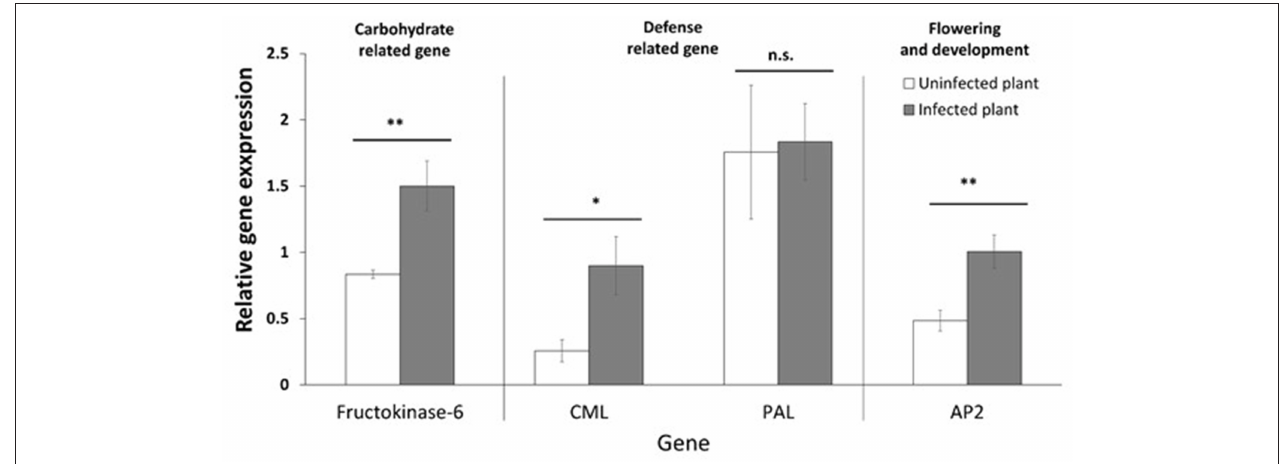
FIGURE 6 | Relative gene expression (mean, ± SE) of selected genes. Asterisk indicates statistically significant differences (* p ≤ 0.05, ** p ≤ 0.01). n.s. = not significant ( p > 0.05).